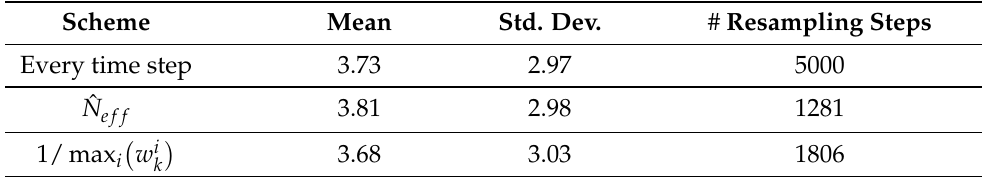
Table 1. Simulation results for 100 simulations with 50 time steps each and three different resampling schemes. Errors are computed by taking the 2-norm of the error (true robot pose vs estimated robot pose). Presented are average error (mean), standard deviation (std. dev.) and the number of times a resampling step has been